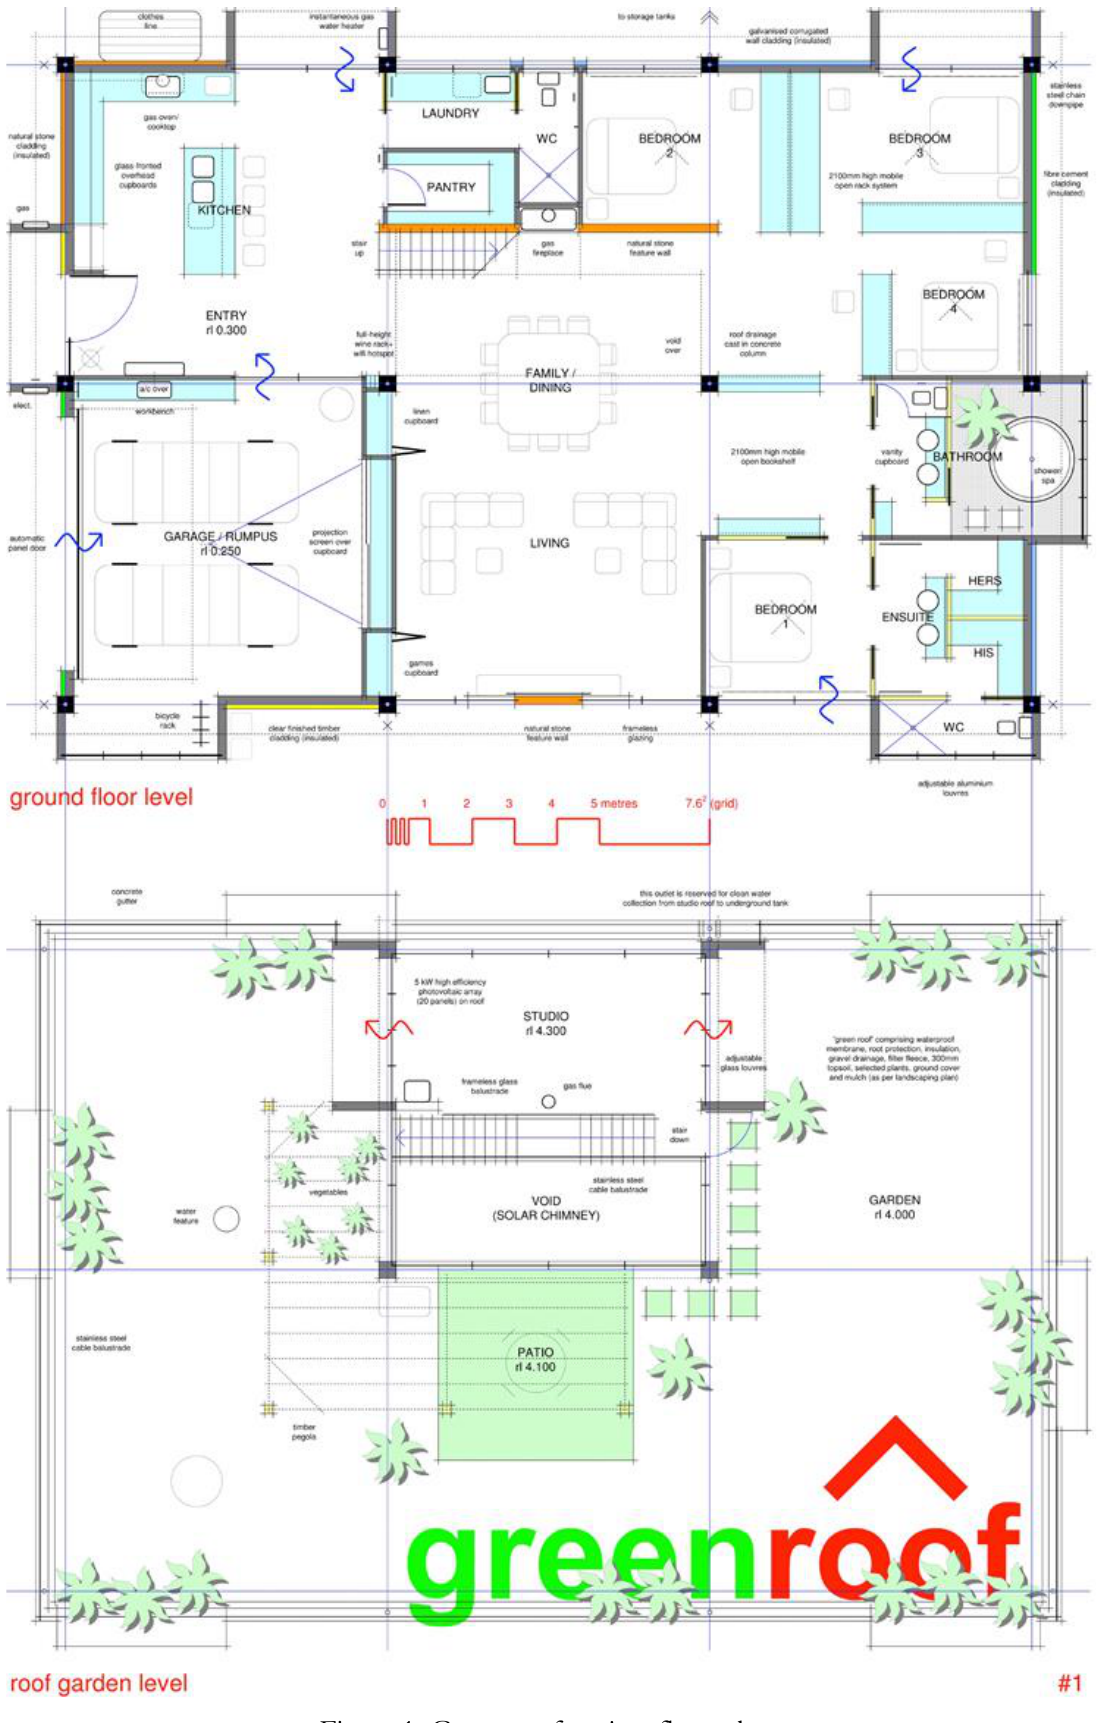
Figure 1: Green roof project floor